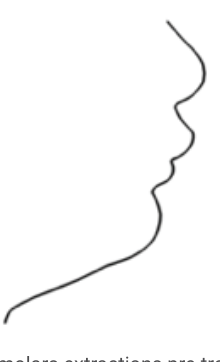
Figure 3. Silhouette of class II premolars extractions pre